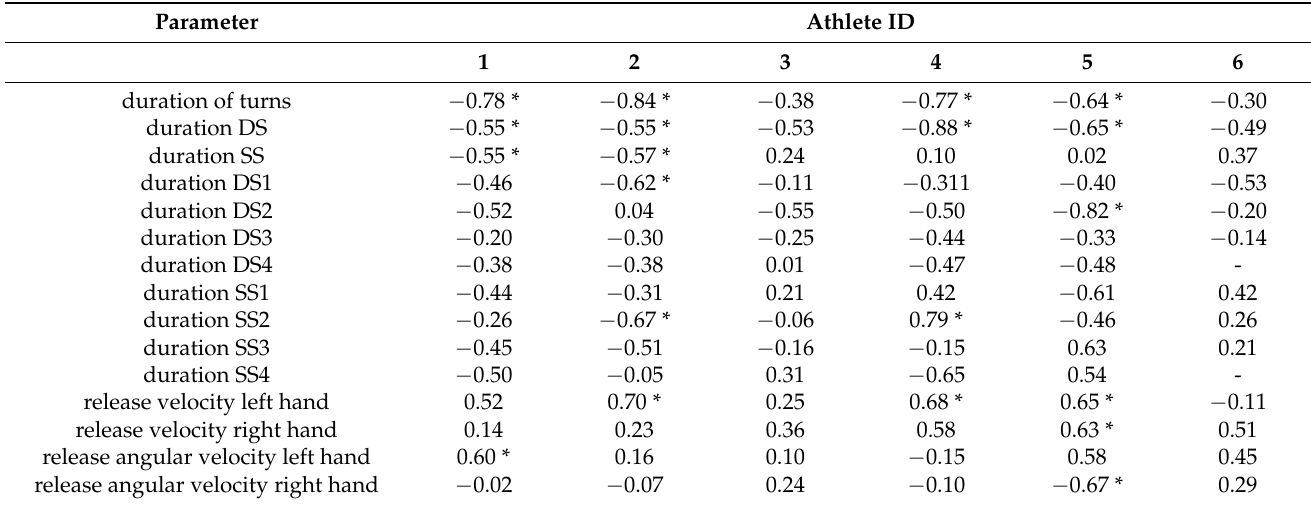
Table 3. Pearson correlation coefficients for main parameters.